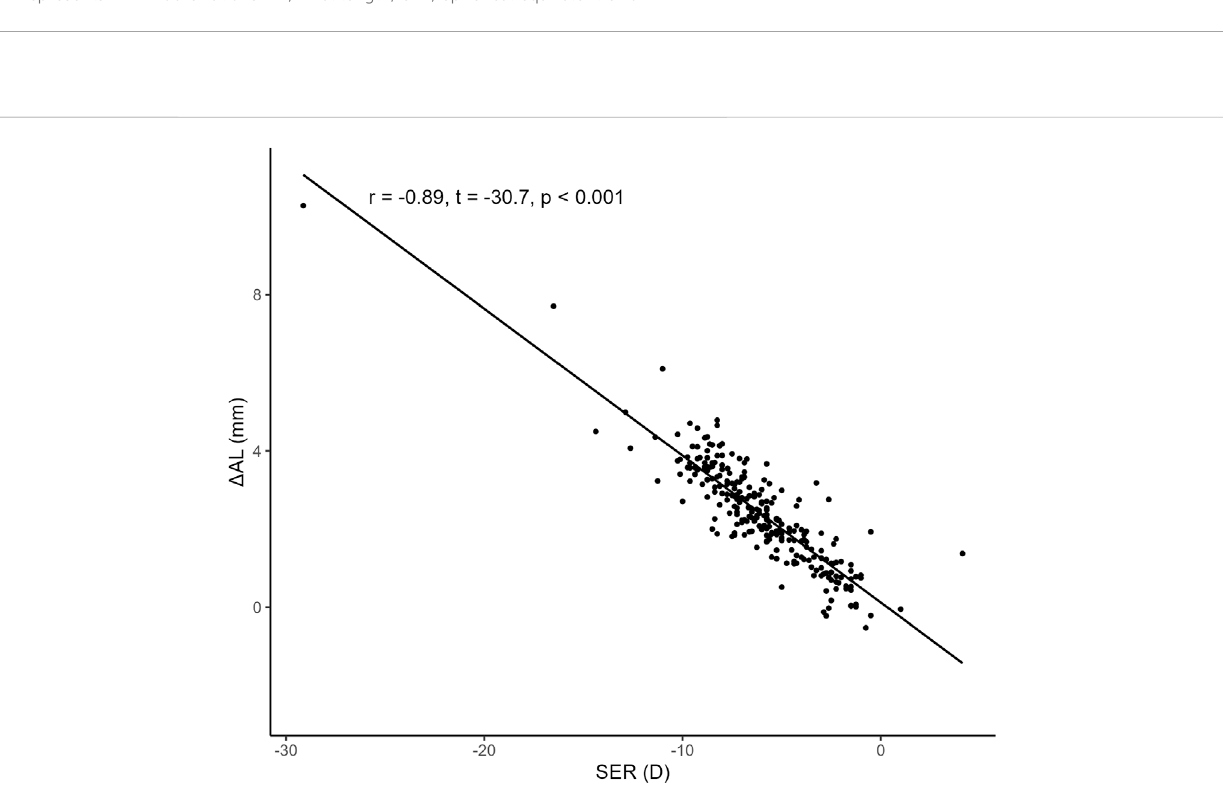
FIGURE 4 Correlation between SER and Δ AL. We found that SER was negatively associated with Δ AL ( r = − 0.89, t = − 30.7, p < 0.001). Abbreviations: SER, Spherical equivalent error; AL, Axial length.